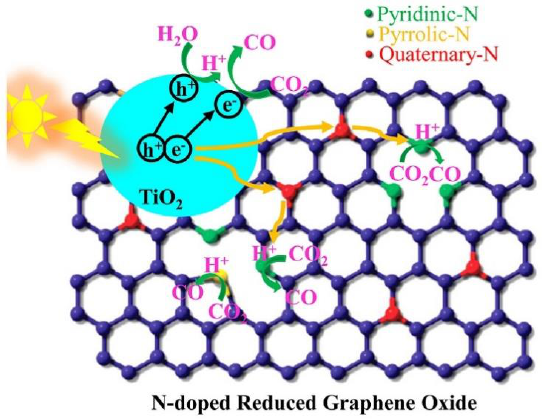
Figure 4. Reaction mechanisms for photoreduction of CO 2 with H 2 O over TiO 2 /NRGO-300 samples. Reprinted with permission from [57]. Copyright 2017, Elsevier. NRGO: nitrogen doped reduced graphene oxide.